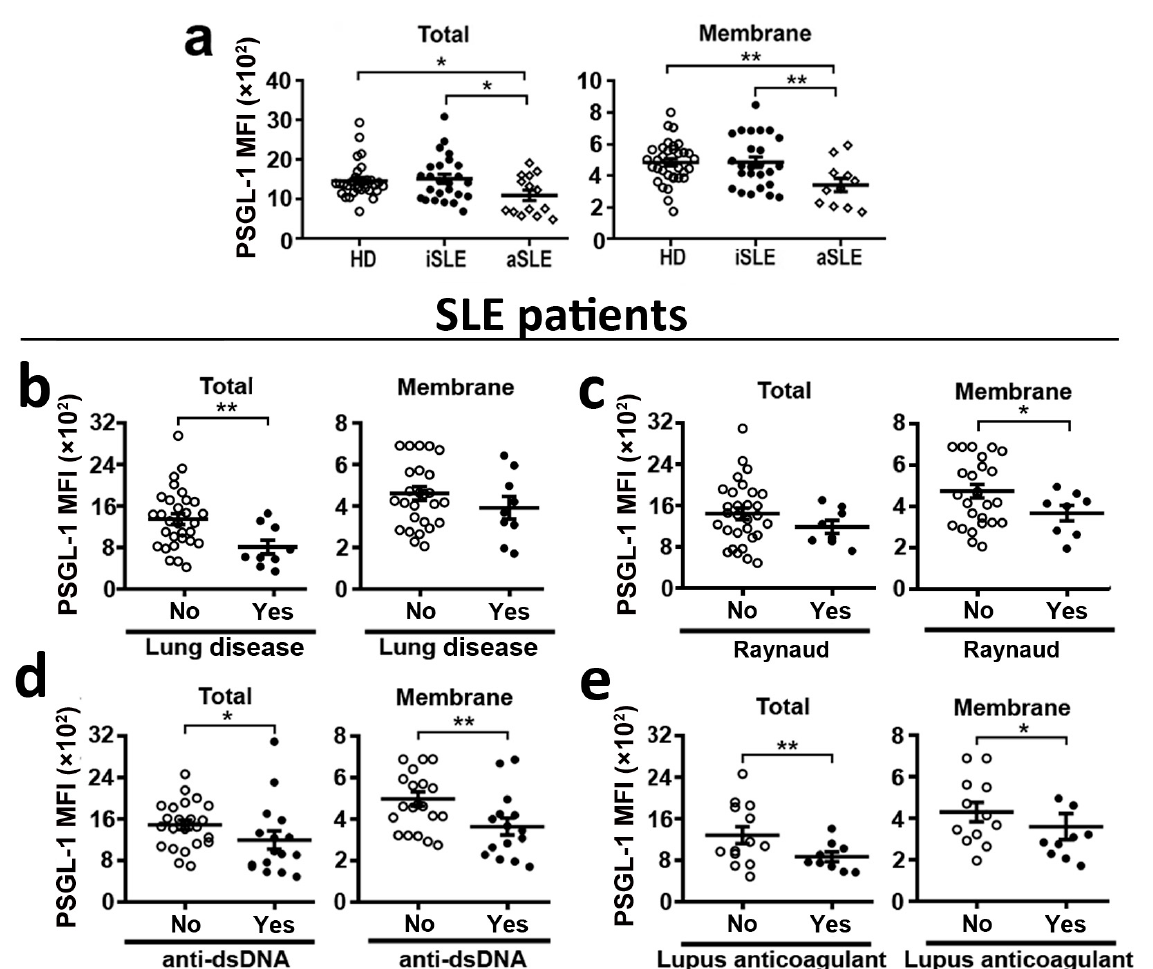
Figure 1. PSGL-1 expression in circulating neutrophils from SLE patients and healthy donors. Expression of PSGL-1 was analyzed by flow cytometry. ( a ) Total (left panel) and membrane (right panel) expression of PSGL-1 in neutrophils from healthy donors (HD, n = 41), inactive SLE patients (iSLE, n = 33), and active SLE patients (aSLE, n = 14). ( b – e ) Association of membrane and total PSGL-1 expression in neutrophils from SLE patients with the presence of different clinical characteristics: ( b ) presence of anti-dsDNA autoantibodies in serum ( n = 47), ( c ) lupus anticoagulant positivity ( n = 25), ( d ) lung disease involvement ( n = 47), and ( e ) presence of Raynaud ´ s phenomenon ( n = 47). Data represent mean fluorescence intensity (MFI) ± SEM. Differences were analyzed by Student’s t -test. * p ≤ 0.05; ** p ≤ 0.01. HD: healthy donors. SLE: Systemic Lupus Erythematosus. iSLE: inactive SLE. aSLE: active SLE.